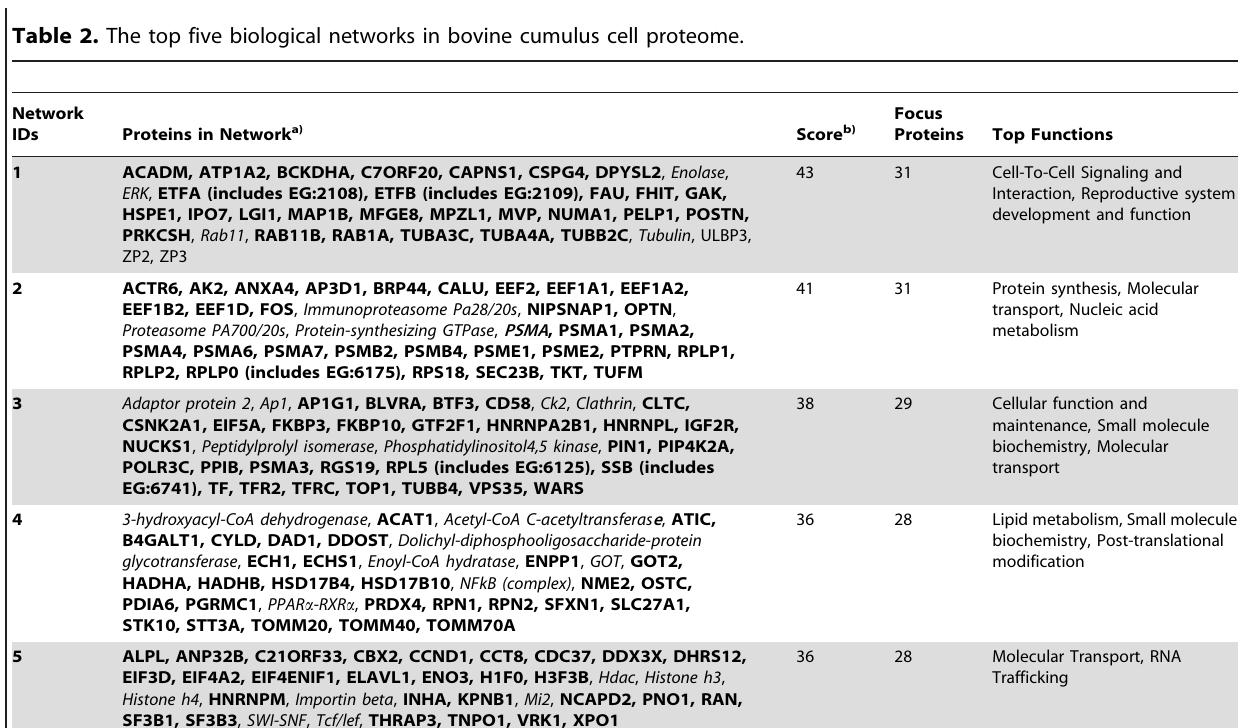
Table 2. The top five biological networks in bovine cumulus cell proteome.